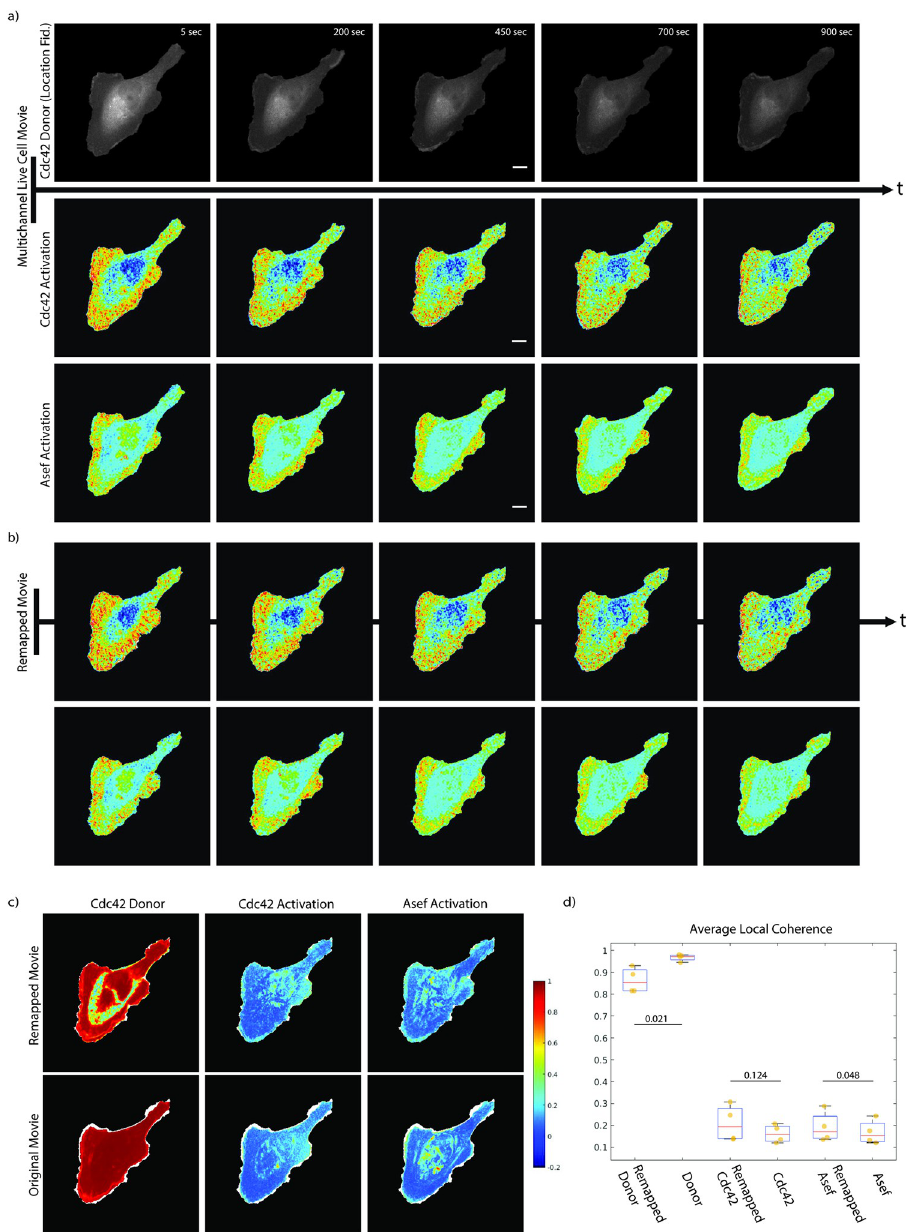
Fig 4. Analysis of spatial coherence in diffuse molecular signals. a) Select frames of a movie visualizing the activation of the GTPase Cdc42 (middle) and its upstream GEF Asef (bottom) using multiplex FRET-based biosensors. Shown are normalized FRET-ratio signal indicating local activation of the molecues. For registration the donor signal of the Cdc42 biosensor is used as the location fiducial (top). b) Remapped, normalized FRET-ratio signals for the same time points as in a). c) Spatial coherence of the Cdc42 donor (left), Cdc42 FRET-ratio (center), and Asef FRET-ratio (right) time-series extracted from the remapped (top) and raw time-lapse sequences. d) Distributions of average spatial coherence of the Cdc42 donor, Cdc42 FRET-ratio, and Asef FRET-ratio time-series. Box plots illustrate 25 th , 50 th , and 75 th percentile of average values in for m = 4 movies. Whiskers indicate the 5 th and 95 th percentile. P-values are calculated by one-way ANOVA testing. Scale bars 10 μ